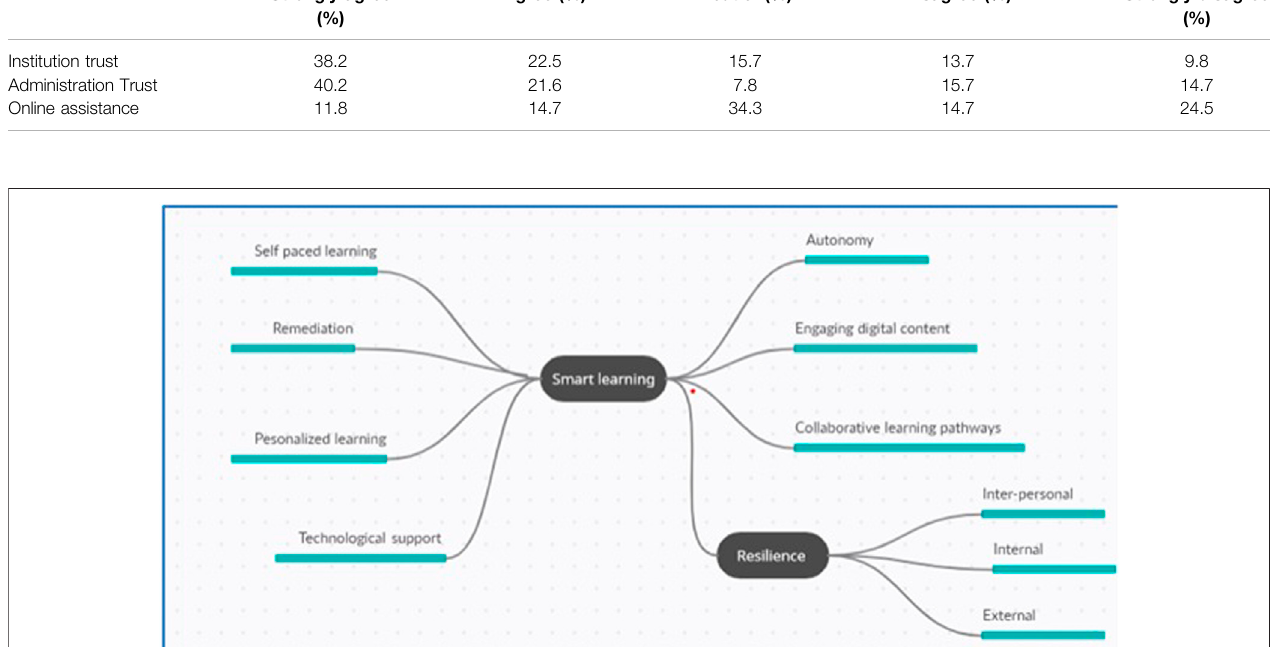
Strongly agree Agree (%) Neutral (%) Disagree (%) Strongly disagree (%)